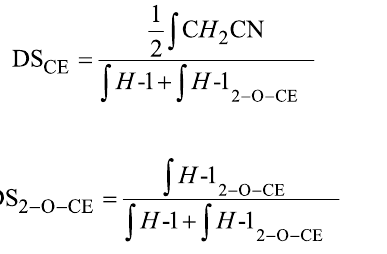
adjacent to the cyano function (C H 2 –CN). The remaining protons of the cyanoethyl substituent overlap with sugar ring protons in the range of 3.3–4.2 ppm. As a result of 2- O -substitu- tion, H -1 is shifted downfield. For the α -1 → 6-glucosyl residues of dextrans (in D 2 O) it is shifted from 4.97 to 5.16 ppm. The average DS value was calculated from the ratio of the signal integrals of the methylene group adjacent to the nitrile group, to the summarized integrals of H -1 (Equation 1). DS evaluation in position 2 is also possible (Equation